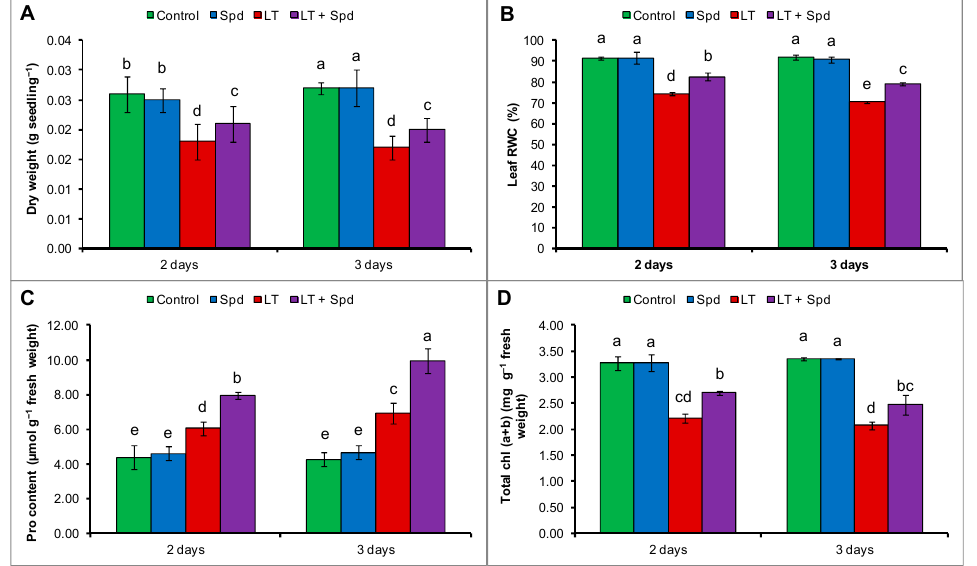
Figure 1. Dry weight per seedling ( A ); leaf relative water content (RWC) ( B ); proline (Pro) content ( C ); and total chlorophyll, chl ( a + b ) content ( D ) in mung bean seedlings. Spd and LT indicate spermidine (0.25 mM) and low temperature (6 °C), respectively. Mean (±SD) was calculated from three replicates for each treatment. Bars with different letters are significantly different at p ≤ 0.05 applying Duncan’s multiple range test (DMRT).